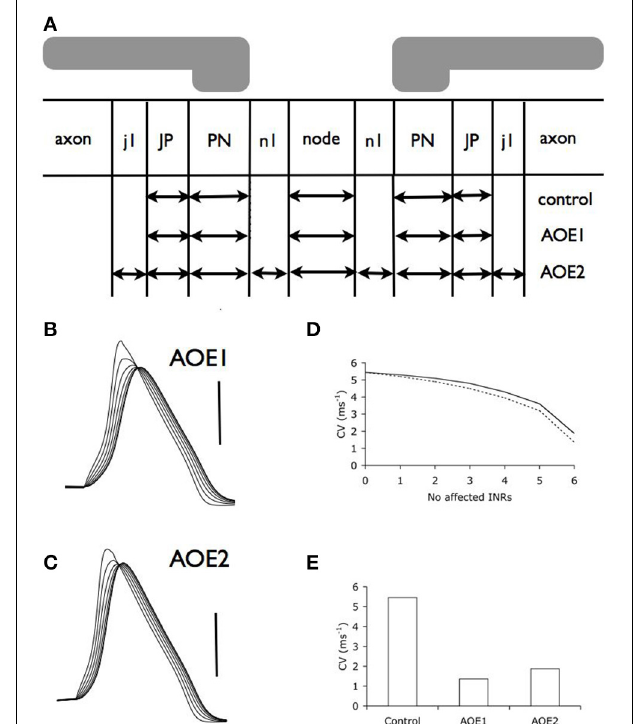
FIGURE 3 | Auditory overexposure decreases conduction velocity. (A) Schematic model of the central portion of the auditory nerve after AOE, illustrating the morphological changes incurred by the nerve. See Table 2 for dimensions of compartments. (B,C) . Action potentials evoked from six successive nodes after AOE1 (B) or AOE2 (C) treatment demonstrated a decreaseintheconductionvelocity.Scalebars50mVin B and C andduration of recording is same as Figure 2B . (D) Incremental decrease in conduction velocity as more INRs are affected by AOE-induced dysmyelination in AOE1 (dotted line) and AOE2 (line) models. (E) Conduction velocity (with an INL of 100 μ m) decreases as a result of both AOE1 and AOE2 (see Methods for